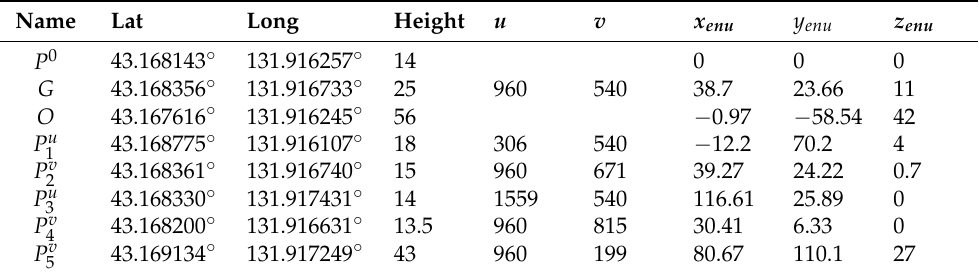
Figure 9. Field of view of the public street camera in Vladivostok. Example 2, image Φ . Table 4. The points used for the calibration. Latitude and longitude are in degrees, altitudes and ENU coordinates are in meters, and coordinates of pixels are in F im units ( u is the column index, v is the